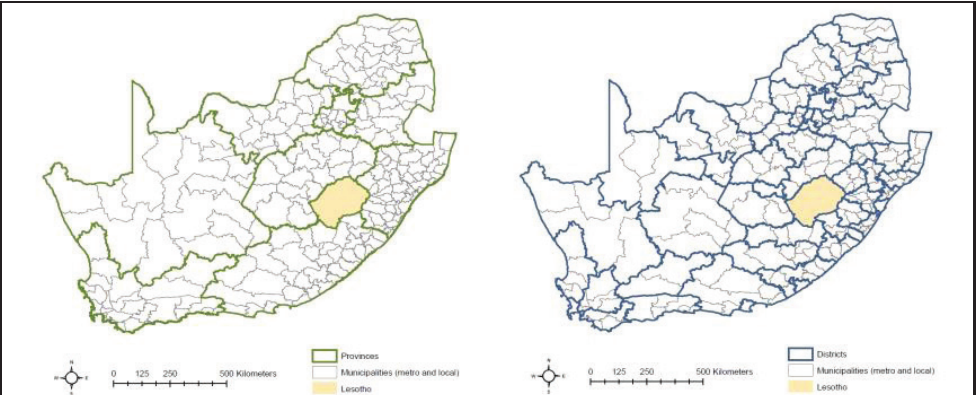
Administrative territorial divisions of South Africa.